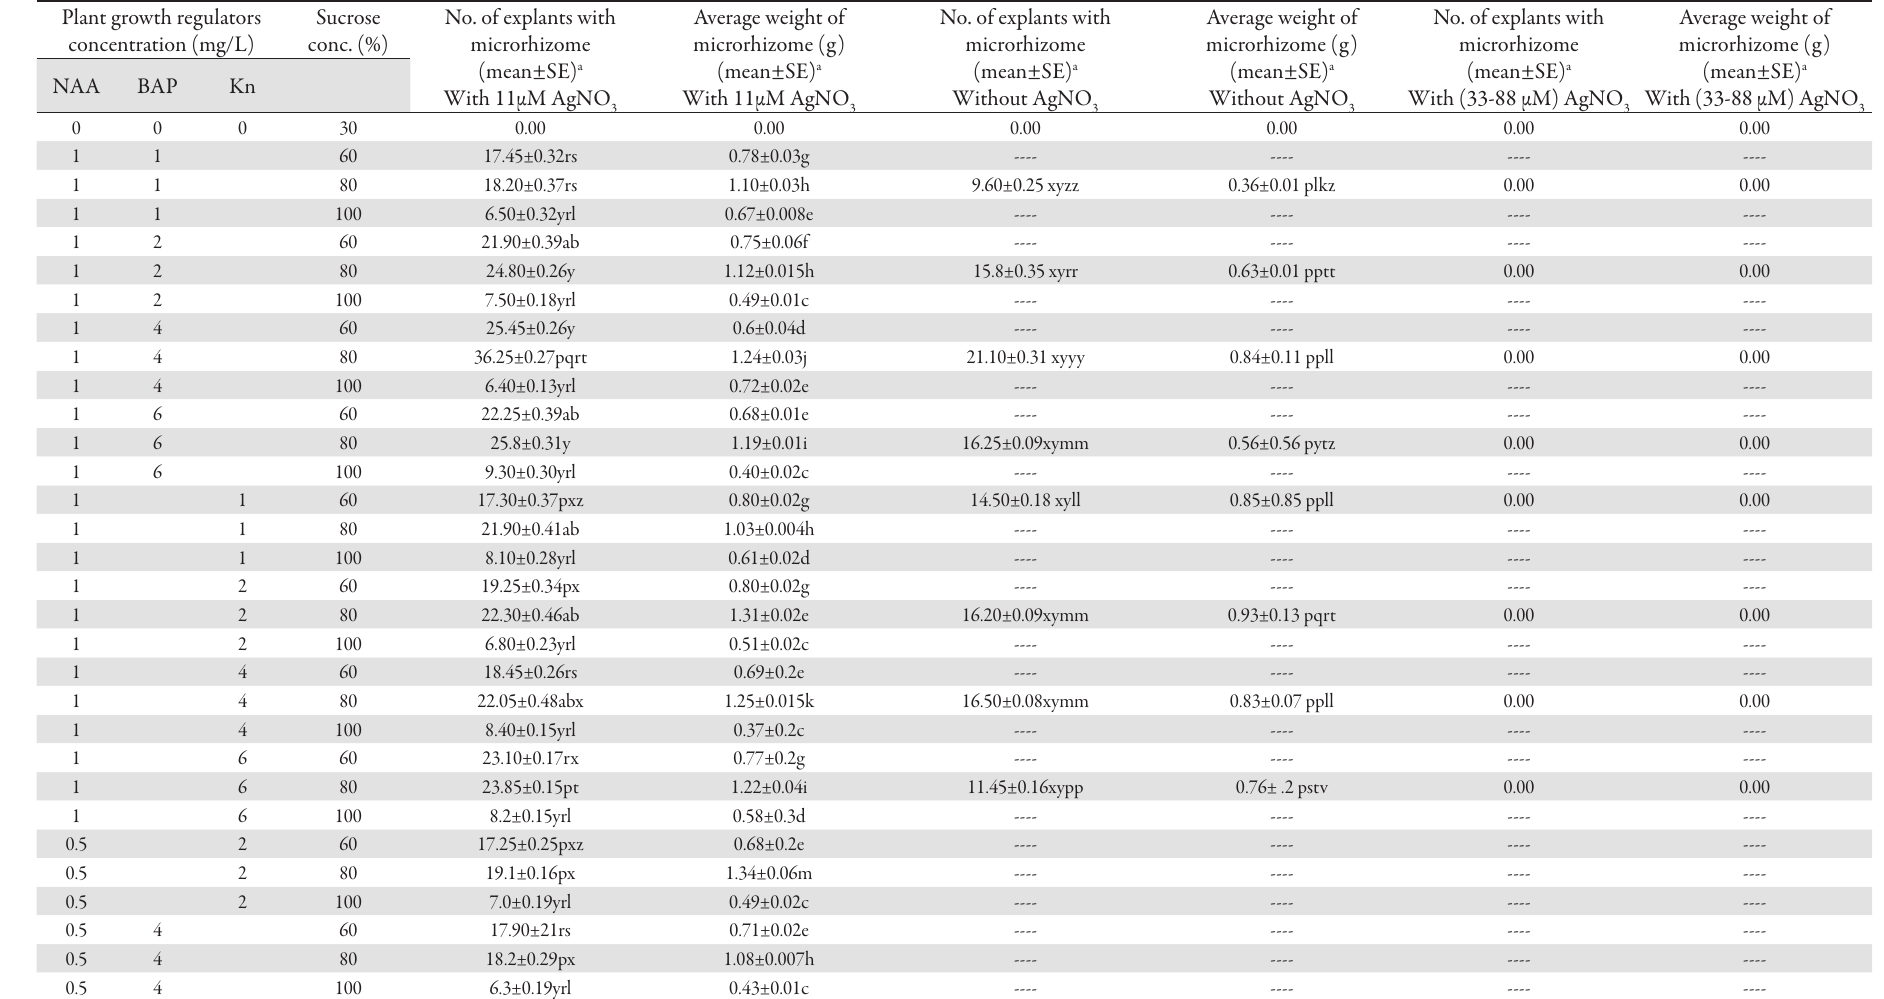
Tab. 4. Effect of different sucrose level, plant growth regulators and with and without silver nitrate in in vitro microrhizome production (n = 20) Plant growth